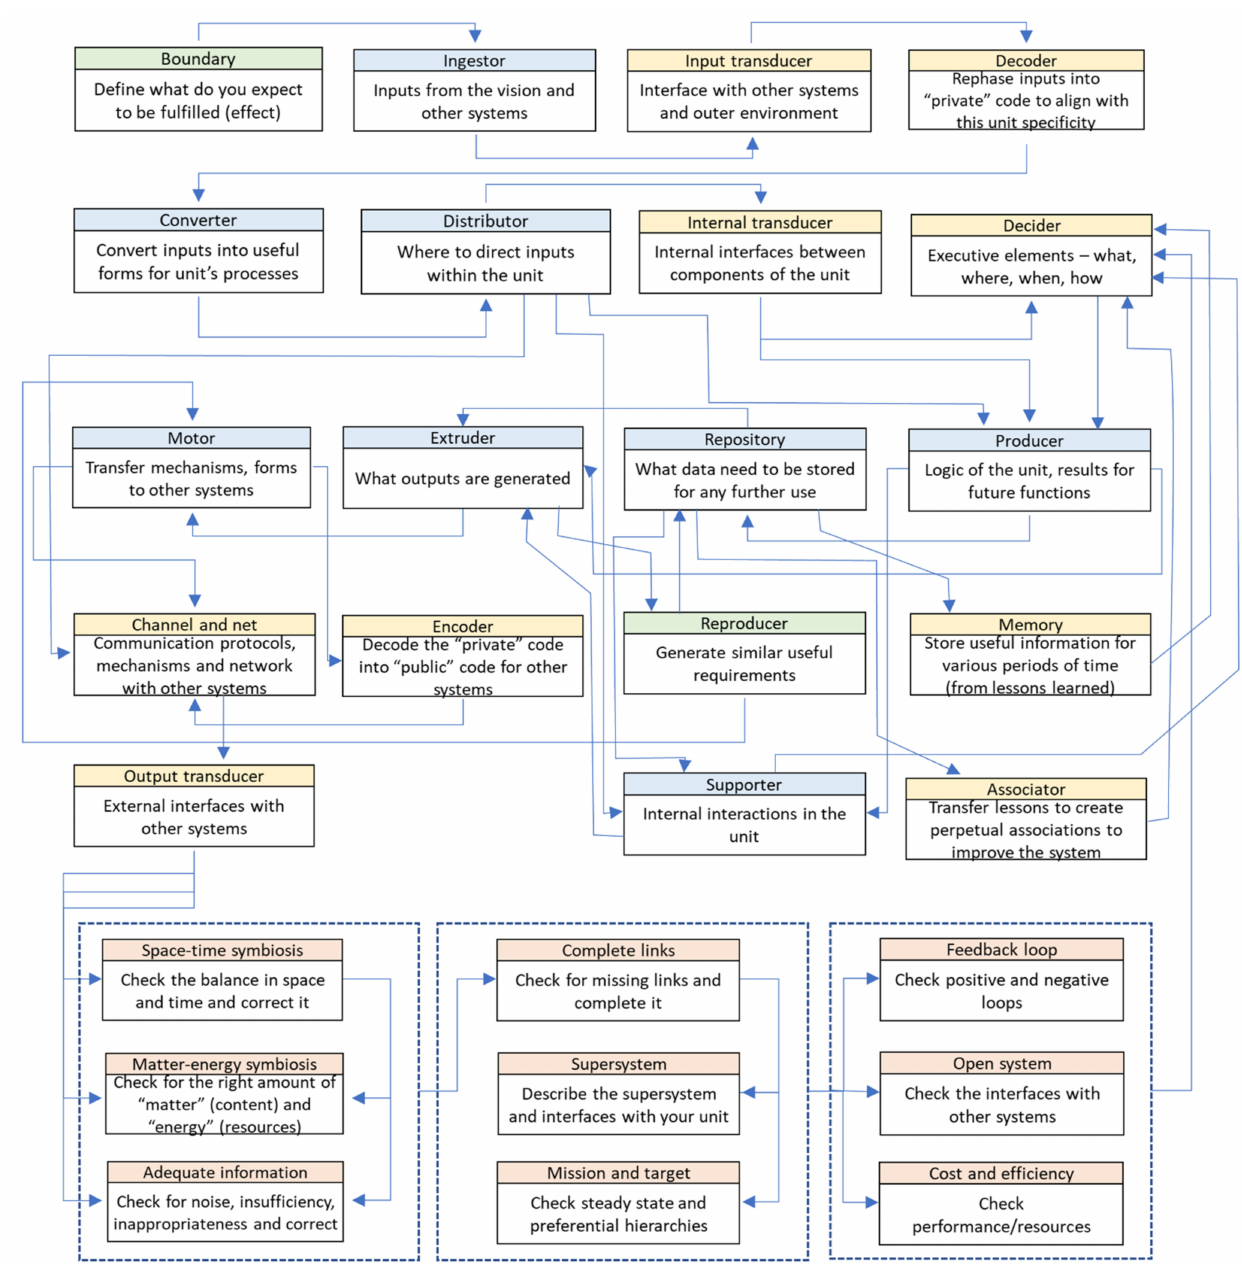
Figure 2. Requirement definition and analysis canvas